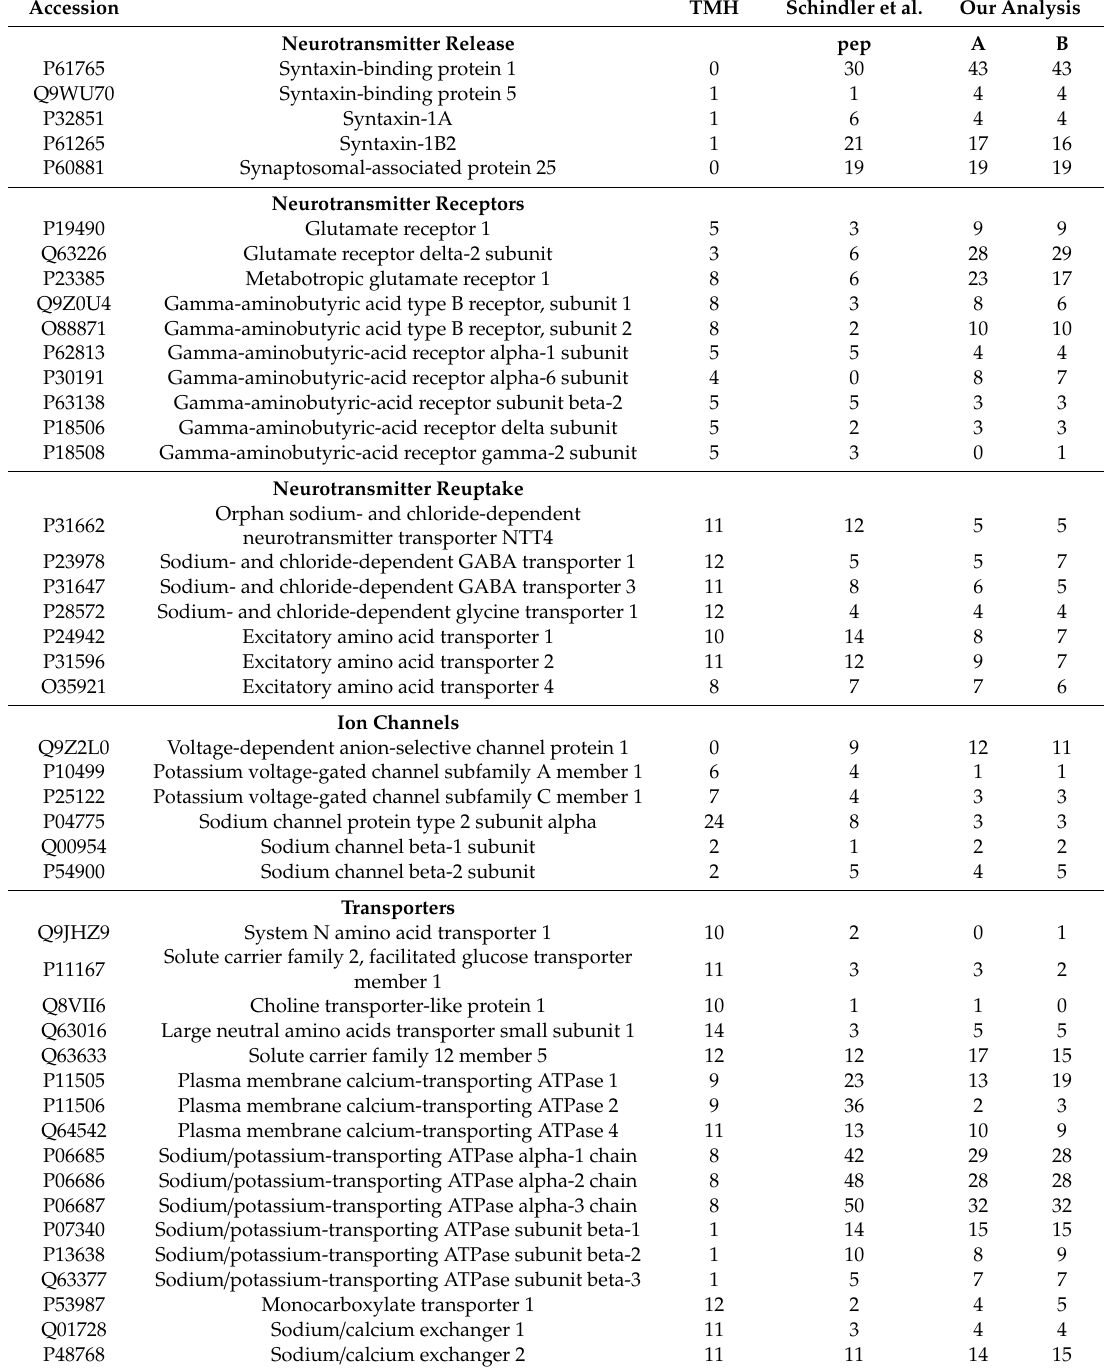
Table 1. Comparison of cerebellar protein